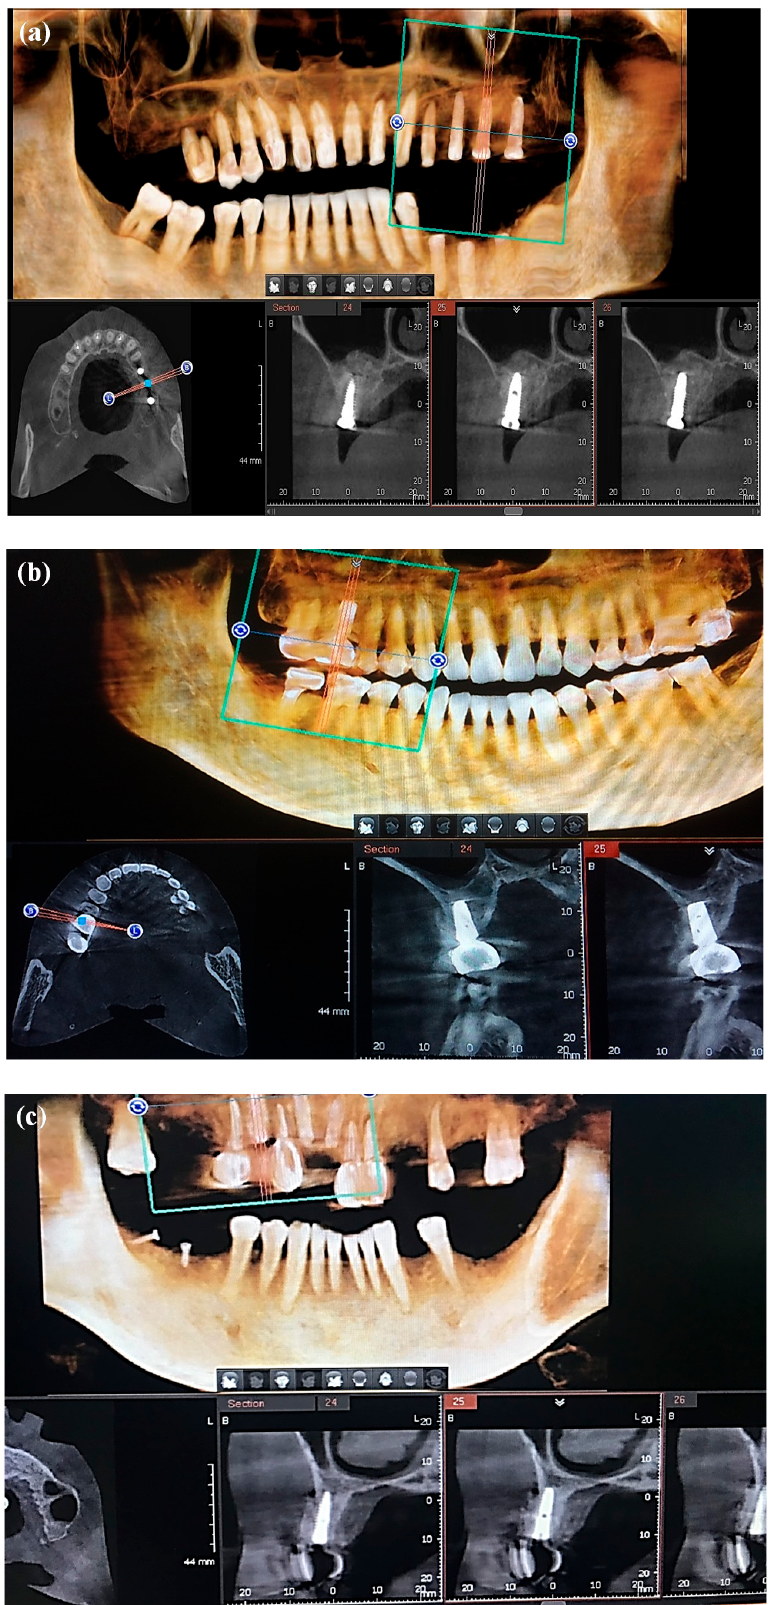
Figure 8. Cone-beam CT images after six months post-treatment in ( a ) the left maxillary region, ( b ) right maxillary molar, and ( c ) right maxillary